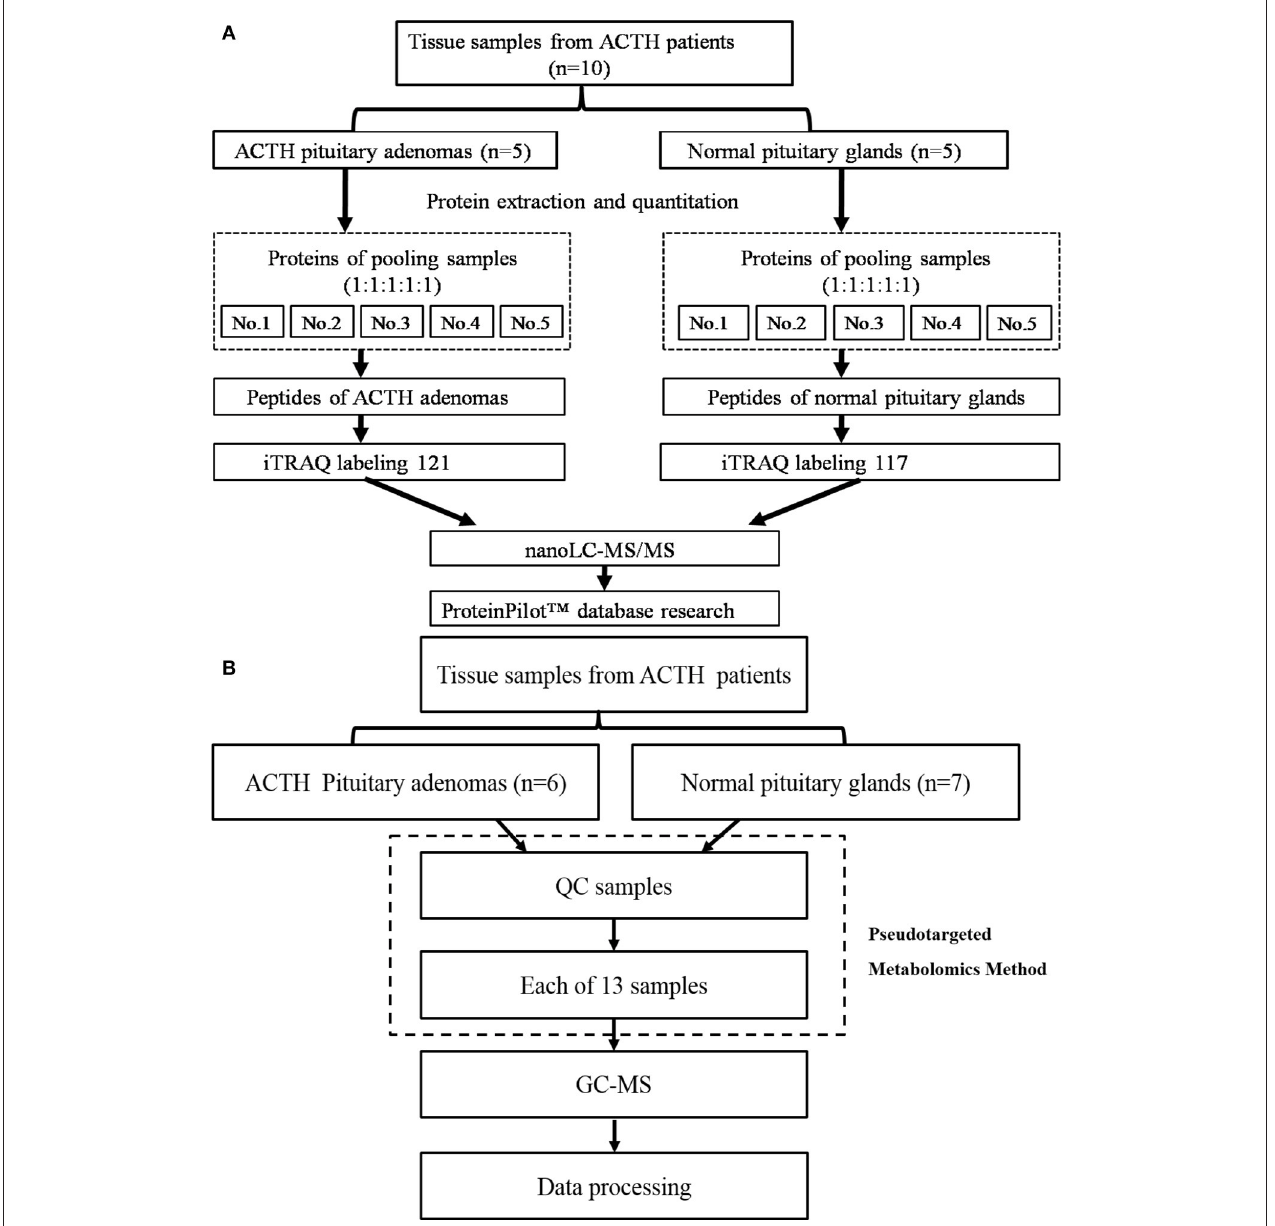
FIGURE 1 | (A) The workflow of the protein preparation and nano LC-MS/MS analysis, (B) The workflow of the metabolomics analysis.